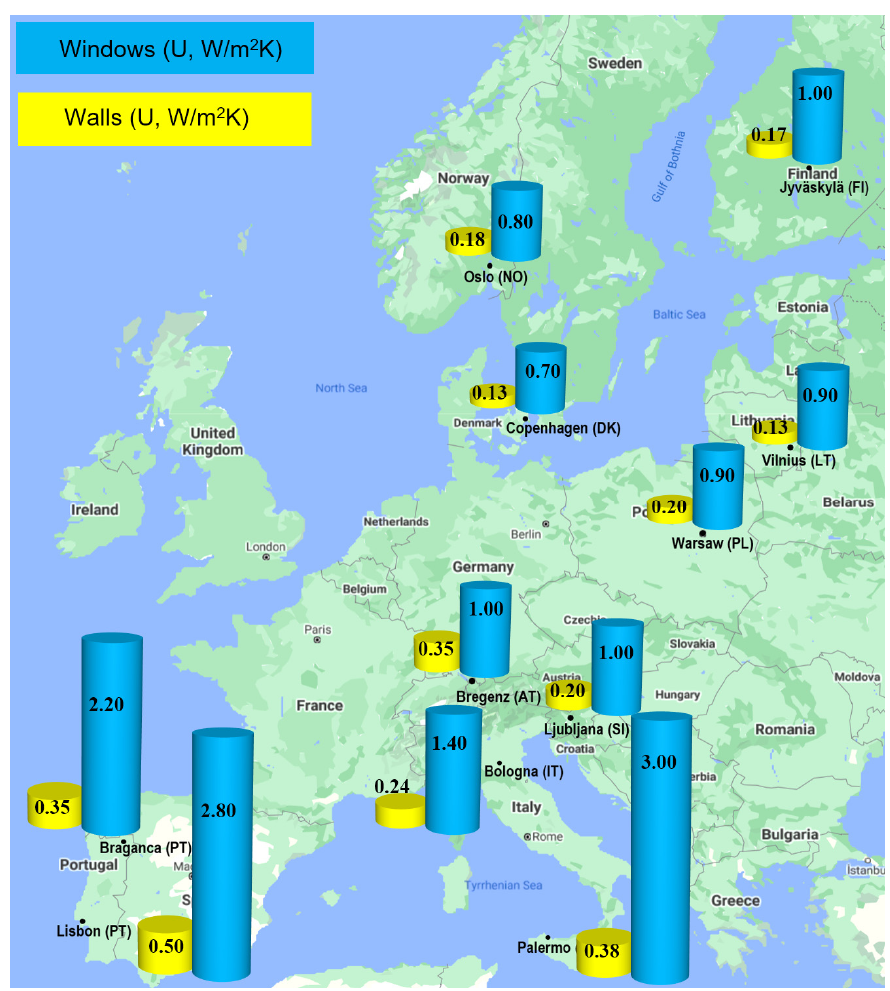
Figure 5. Heat transfer coefficient values of the exterior walls and windows of a building in the subject countries.